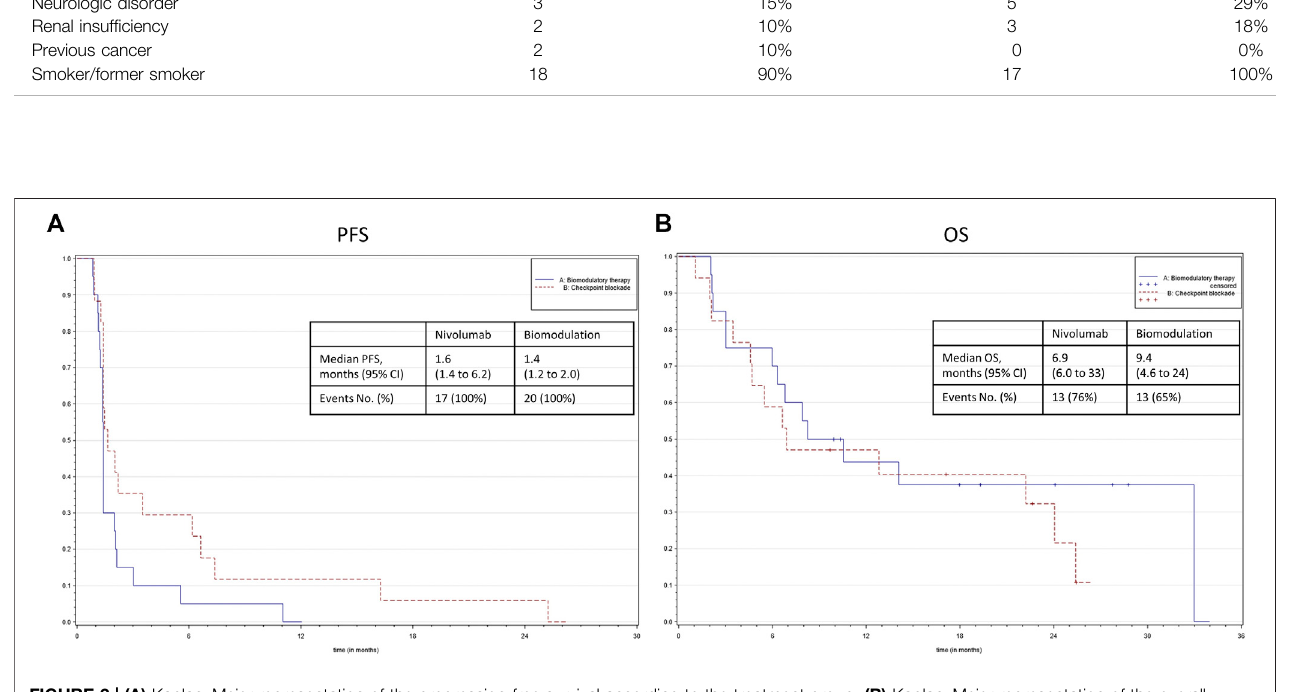
FIGURE 2 | (A) Kaplan – Meier representation of the progression-free survival according to the treatment group. (B) Kaplan – Meier representation of the overall survival according to the treatment group.